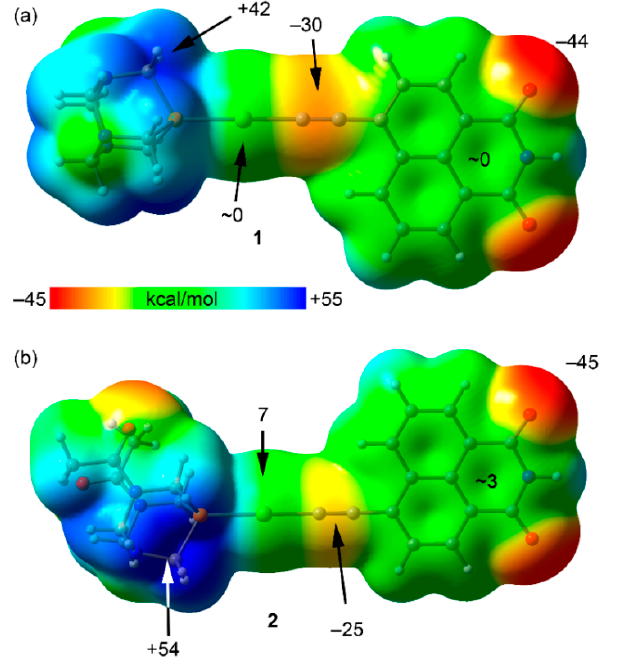
Figure 3. MEP surfaces (isovalue 0.001 a.u.) of compounds 1 ( a ) and 2 ( b ). The values at selected points of the surfaces are indicated in kcal/mol.